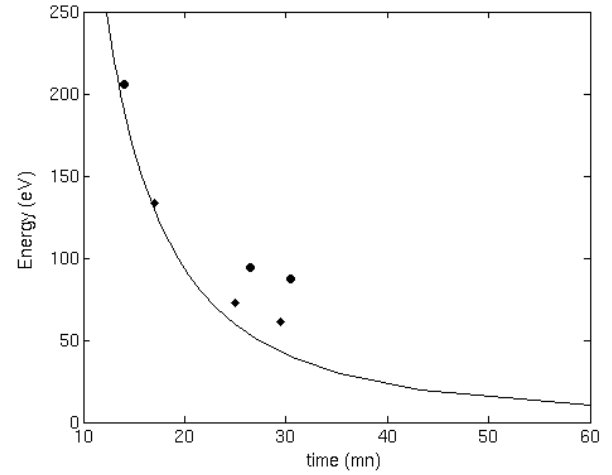
Fig. 8. Time evolution of the energy of the ion structures as deduced from 3 satellite measurements for the 28 September 2001 event. Points correspond to the structure number 1 and the diamond- shaped symbols to the structure number 2 (the number refers to the structures’ label as given in Fig. 7). The line represents the time of flight of O + ions, deduced from a dipolar model.